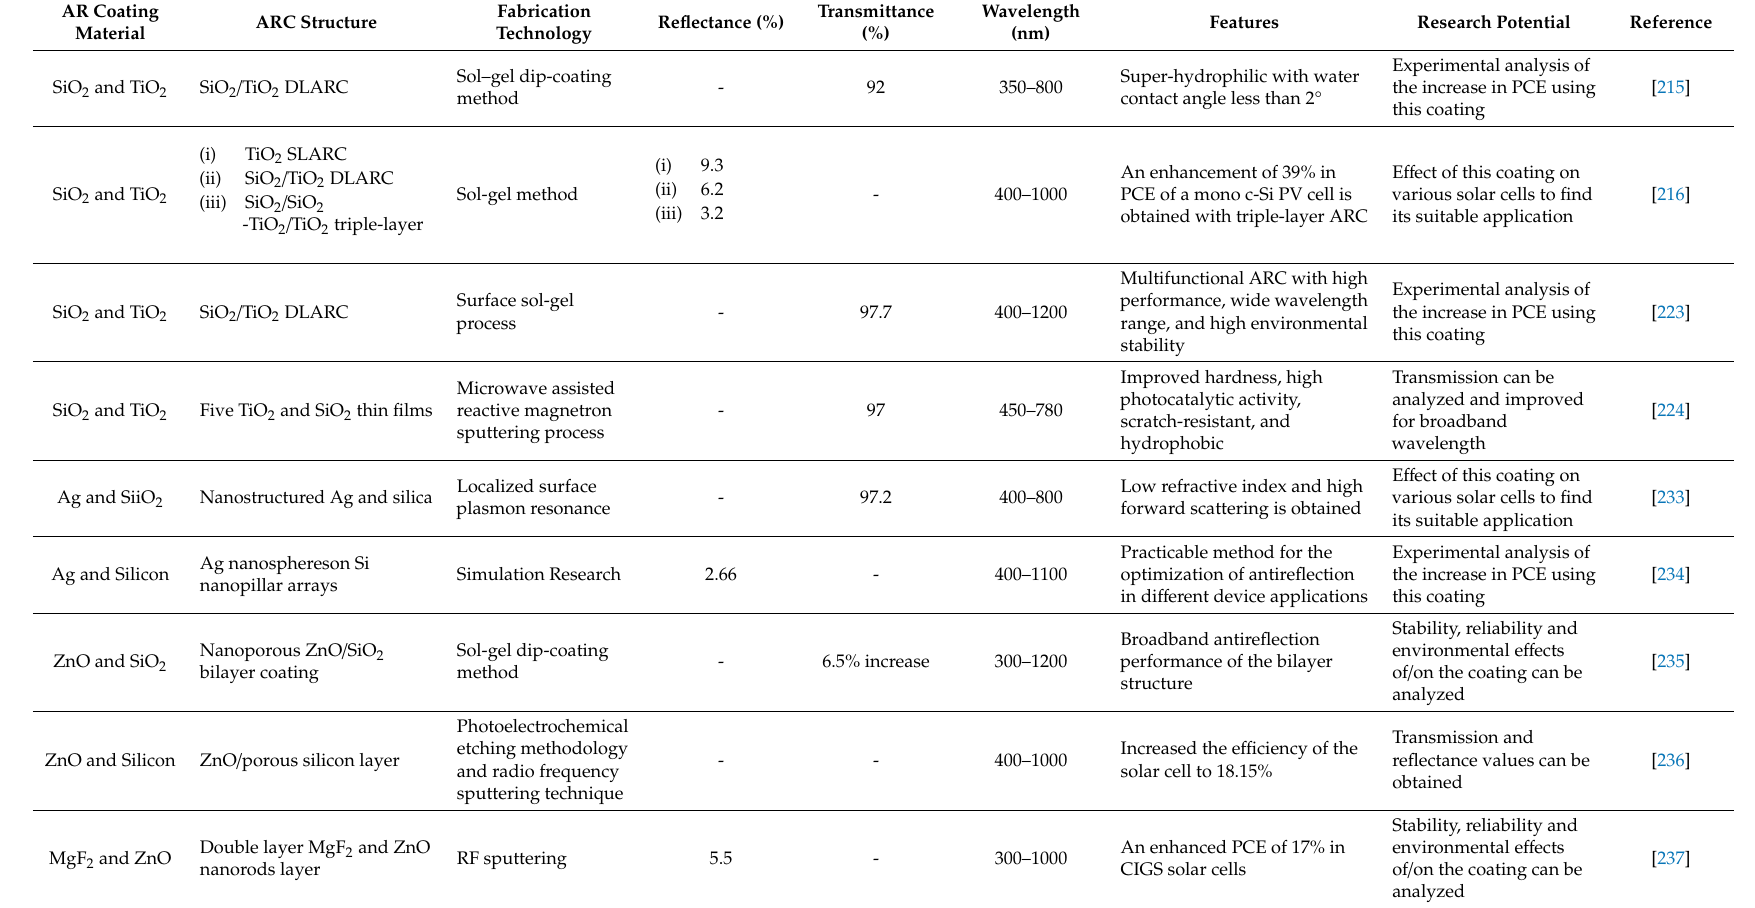
Table 6. Composite material antireflection